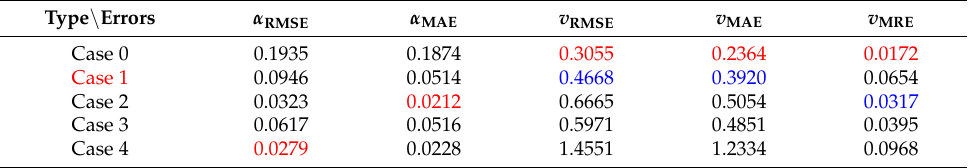
Figure 6. Prediction errors for surrounding vehicles based on different methods. Table 3. Prediction errors for ego vehicle based on DBN with one